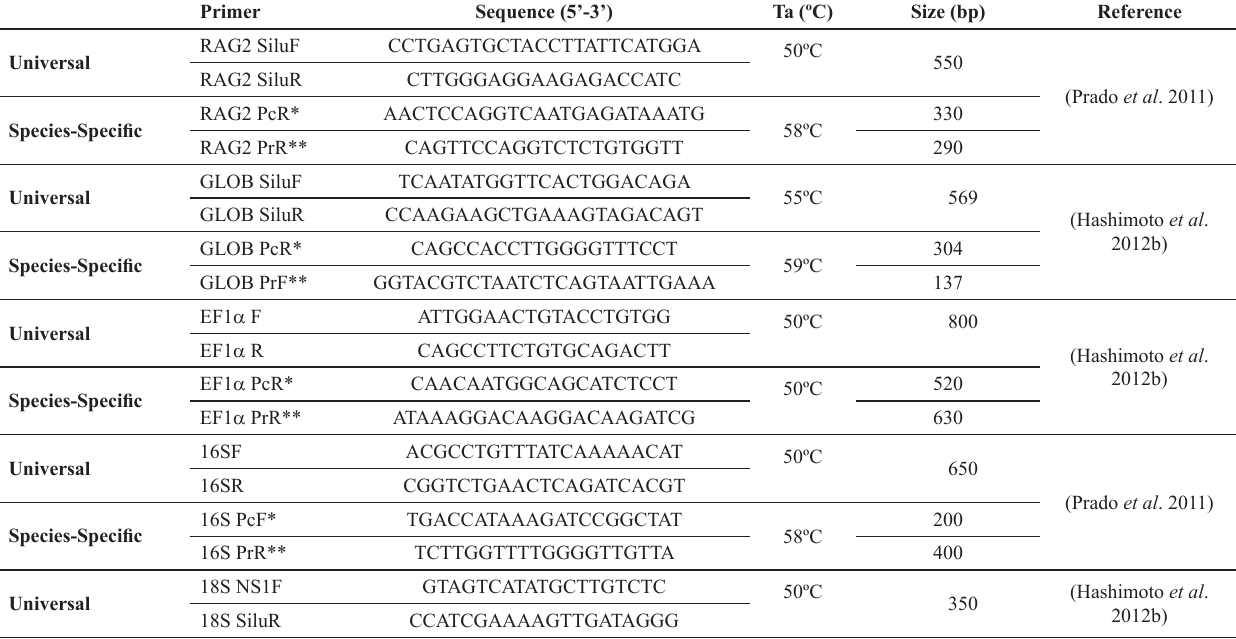
Table 1. Description of universal and species-specific primers; Annealing temperature (Ta) in degree Celsius (°C); Size of fragments in base pairs (bp) used in amplification reactions. *Specific for P. corruscans; ** Specific for P. reticulatum